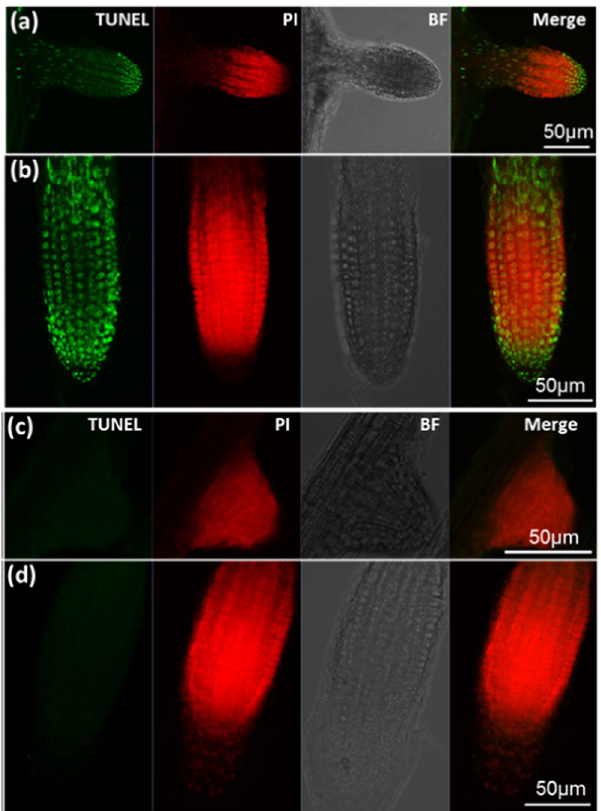
Figure 4. TUNEL labeling in PR and LR during lethal salinity. Roots of Arabidopsis plants that were treated with 200 mM NaCl for 24 or 48 hours, were labeled with TUNEL as mentioned in methods. ( a , b ) Shown are the representative confocal microscopy images of TUNEL positive control of LR and PR that were treated with DNase-I for 20 min. The green punctate structure represents nuclei with fluorescein labelled nick and PI was used as a counterstain to locate cell nuclei. ( c,d ) Are the representative images of TUNEL labeled roots that were salt stressed for 48 hours (similar results were obtained during 24 HAS). The lack fluorescein labelling in the LR ( c ) and PR ( d ) clearly indicate the absence of DNA nicking in these tissue under toxic salinity conditions. The experiment was repeated twice (n = 7–10